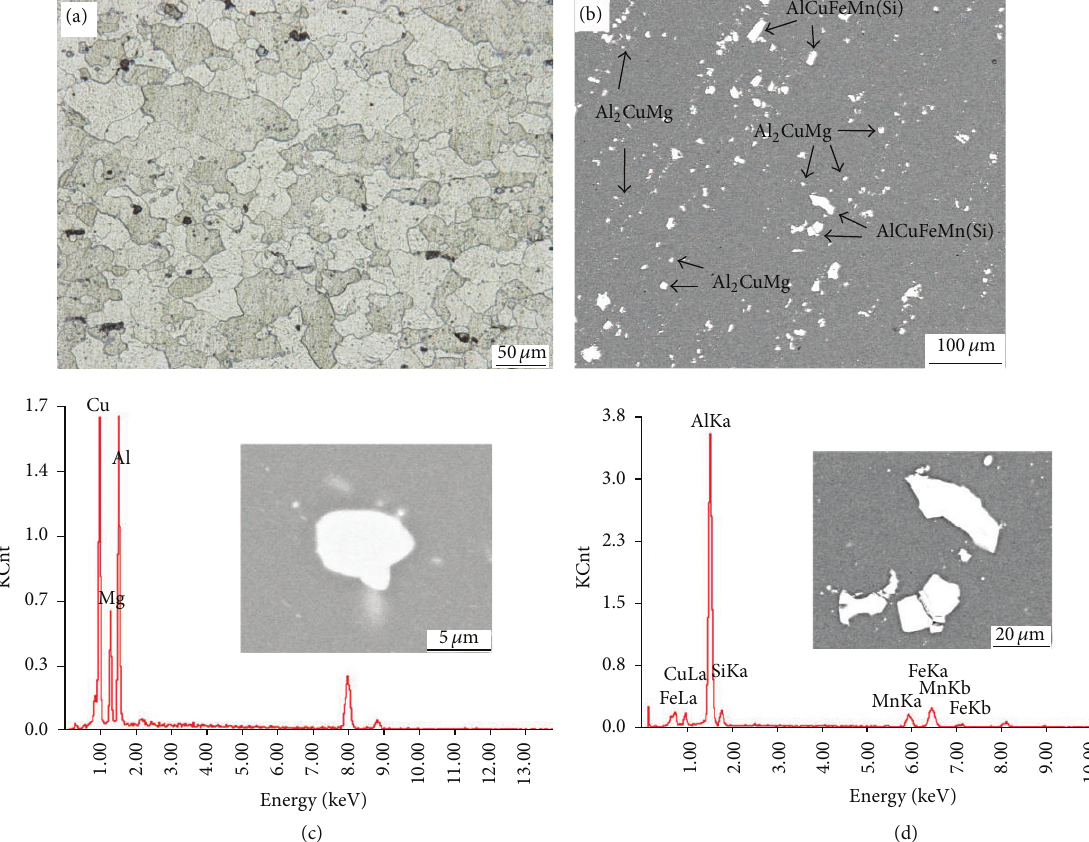
Figure 1: Microstructure of 2A12 aluminum alloy used in this work: (a) optical micrograph, (b) SEM images of the distribution of second phases, (c) EDS of AlCuMg particles, and (d) EDS of AlCuFeMnSi particles. Table 2: Climatic parameters and atmospheric pollutants of Xisha islands during 4 years of exposure. Exposure